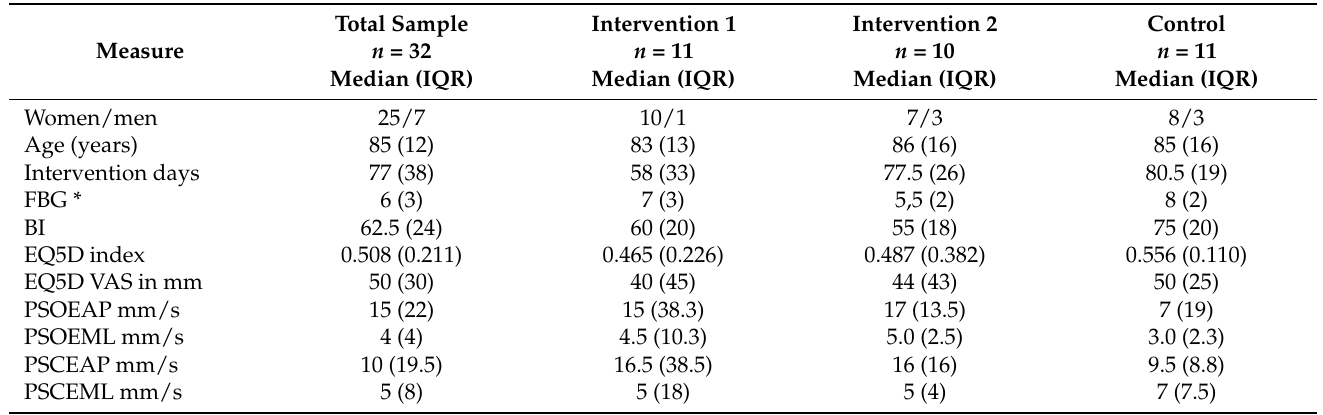
Table 3. Median and interquartile range (IQR) for baseline measures for the total group and the total group divided into intervention groups 1 and 2 and the control